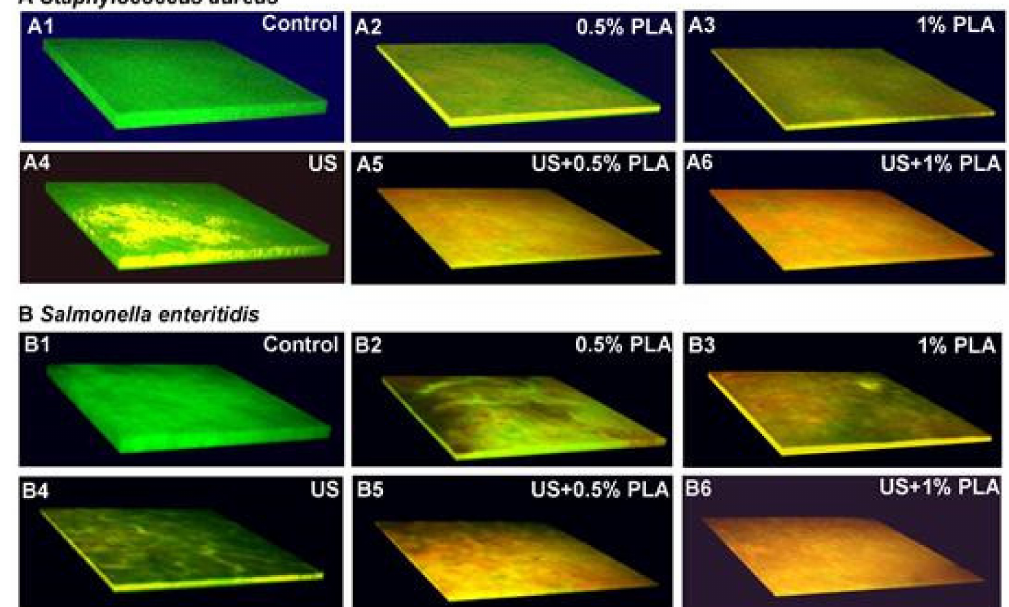
Figure 2. Confocal laser scanning images of S. aureus ( A ) and S. enteritidis ( B ) after the single and combined treatment of US and PLA for 30 min. US: Ultrasound; PLA: Phenyllactic acid; US + PLA: Ultrasound combined with